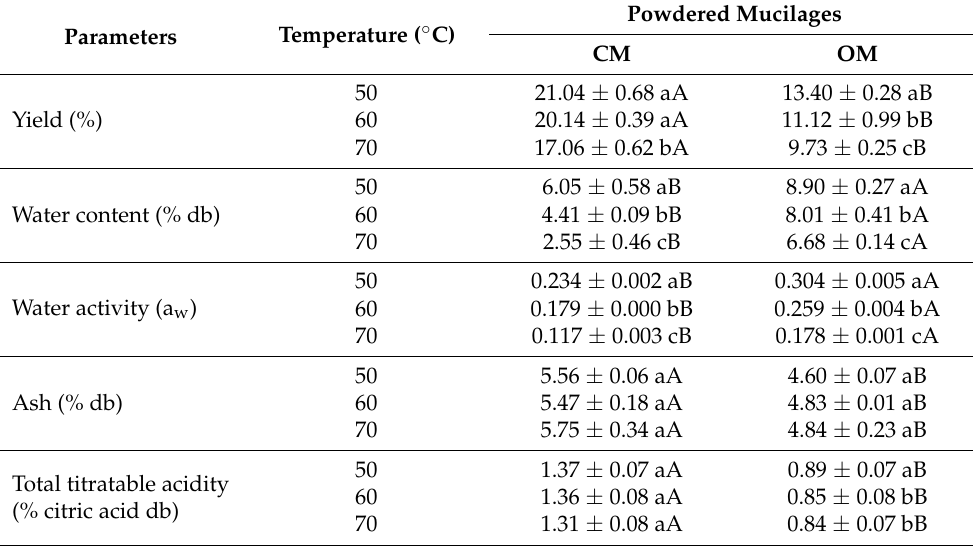
Table 1. Mean values and standard deviations of the chemical and physicochemical parameters of chia (CM) and okra (OM) mucilage powders obtained at different drying